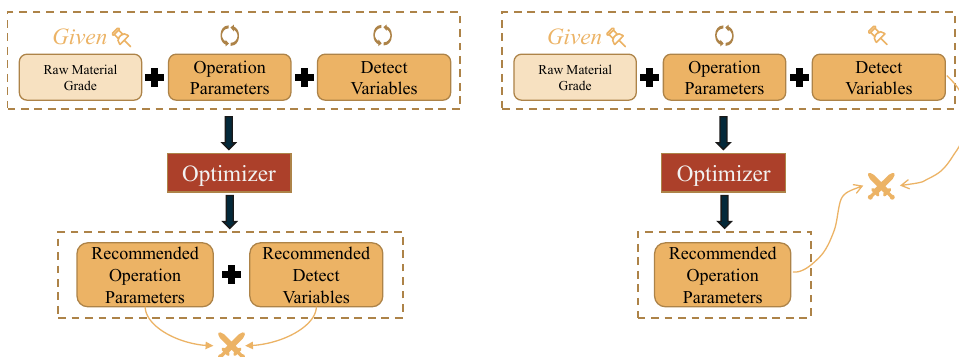
Figure 4. Illustration of the inconsistency of traditional methods’ optimization